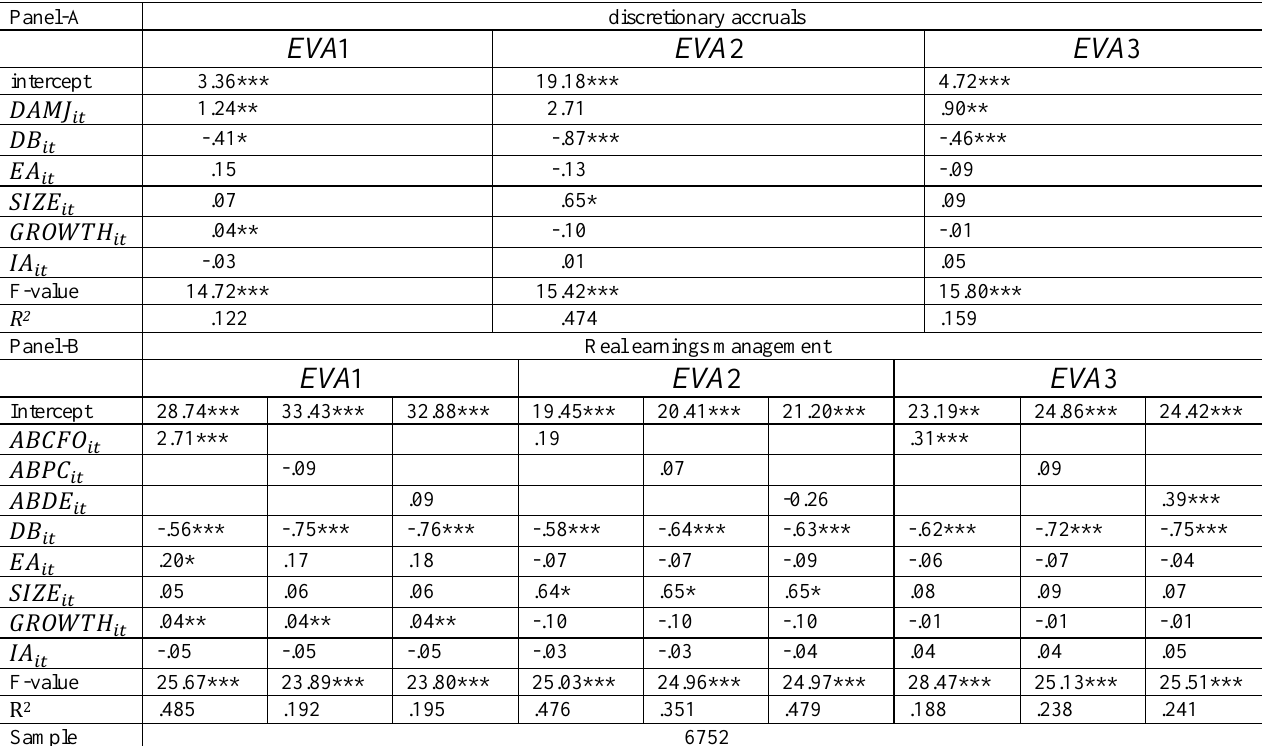
Table 5: Regressions of earnings management with economic value added (EVA) for newly industrialized countries (NICs) Panel-A